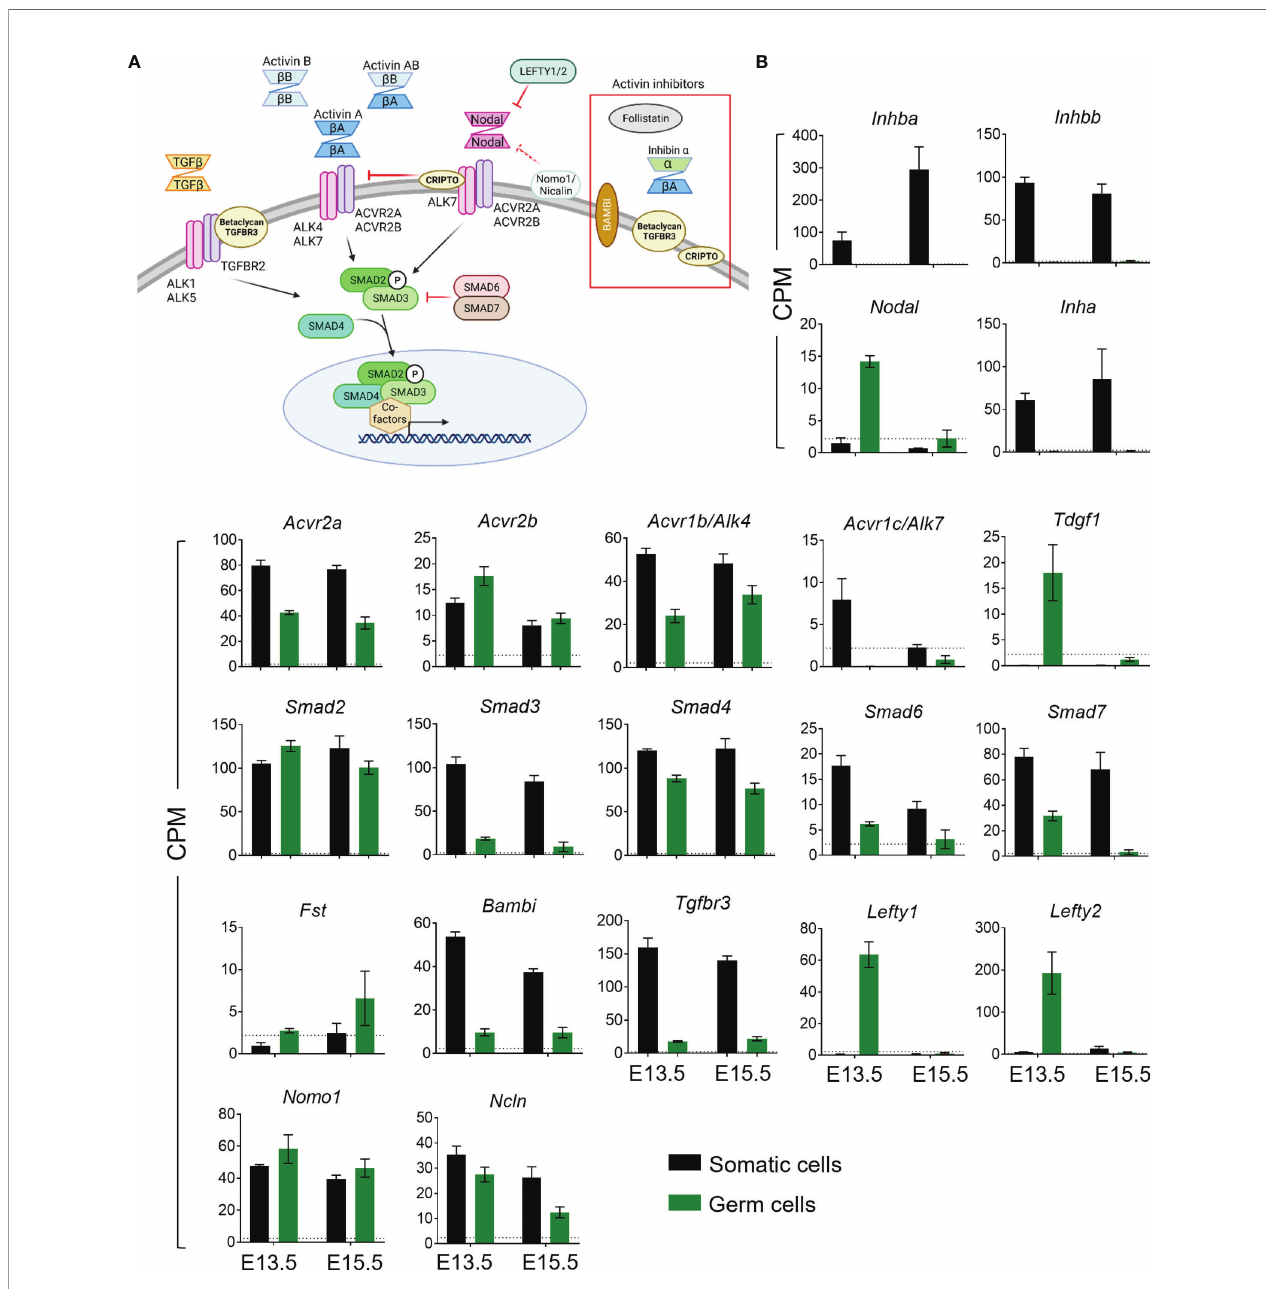
FIGURE 1 | Activin and Nodal signalling component expression pro fi les in somatic and germ cells from wildtype E13.5 and E15.5 testes. (A) Overview of activin/Nodal/TGF b signalling pathway and modulators. Dimeric ligands bind to two Type 2 receptors with a constitutively active serine-threonine kinase (STK) (purple) which then recruit, phosphorylate and thereby activate Type 1 receptor subunits with STK activity (pink). The complex can phosphorylate SMADs 2 and 3, and two of these complex with SMAD4 for transport into the nucleus, where interactions with nuclear co-factors effect changes in gene transcription. Crosstalk between family members is a feature of this pathway. This is mediated by the shared utilization of receptors (e.g. between activin A and Nodal), SMADs (common to activin/Nodal/TGF b ), and the inhibitory impact of Nodal pathway components (e.g. Cripto and Lefty1/2) on activin A signaling. (B) RNA- sequencing was performed on somatic and germ cell populations isolated from E13.5 and E15.5 Inhba x Oct4-Gfp mouse testes. The somatic cell data was published previously (9). Transcript levels of activin and Nodal ligands, type 1 and type 2 receptors, intracellular Smads, and activin and Nodal inhibitors in wildtype somatic (black columns) and germ cells (green columns) are shown in counts per million (cpm). Data are presented as mean ± SD. The detection limit for the Inhba x Oct4-Gfp RNA-Seq data set was 2.2 cpm (dotted